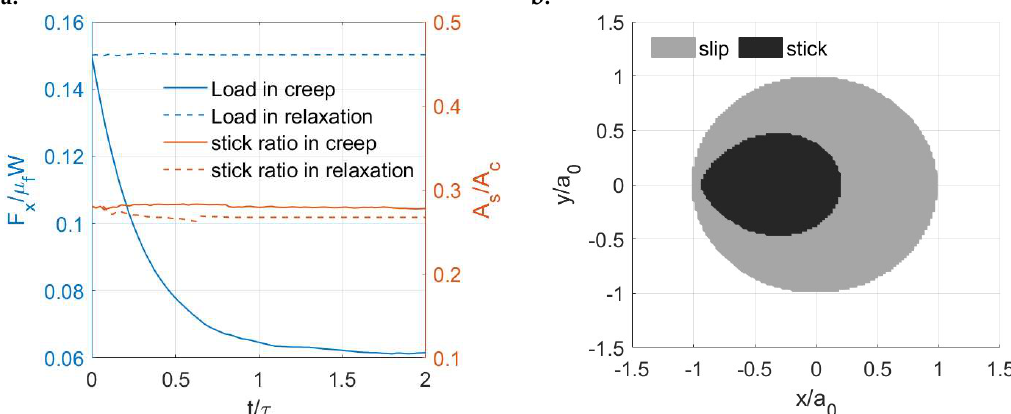
Figure 21. ( a ) Variations in the resulting tangential loads ( y axis left) and stick ratios ( y axis right) with time in the relaxation (solid line) and creep (scatter) cases and ( b ) Time-independent separation pattern of the stick (dark) and slip (grey) regions in the relaxation